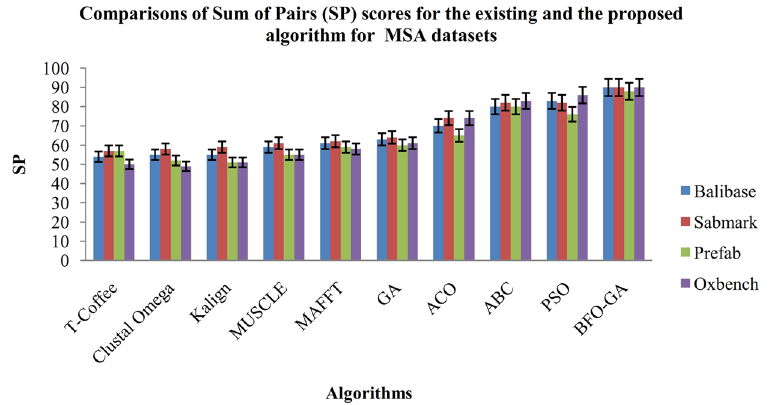
Figure 9. Comparison of Sum of Pairs (SP) scores for the existing and the proposed algorithm for the MSA Datasets.